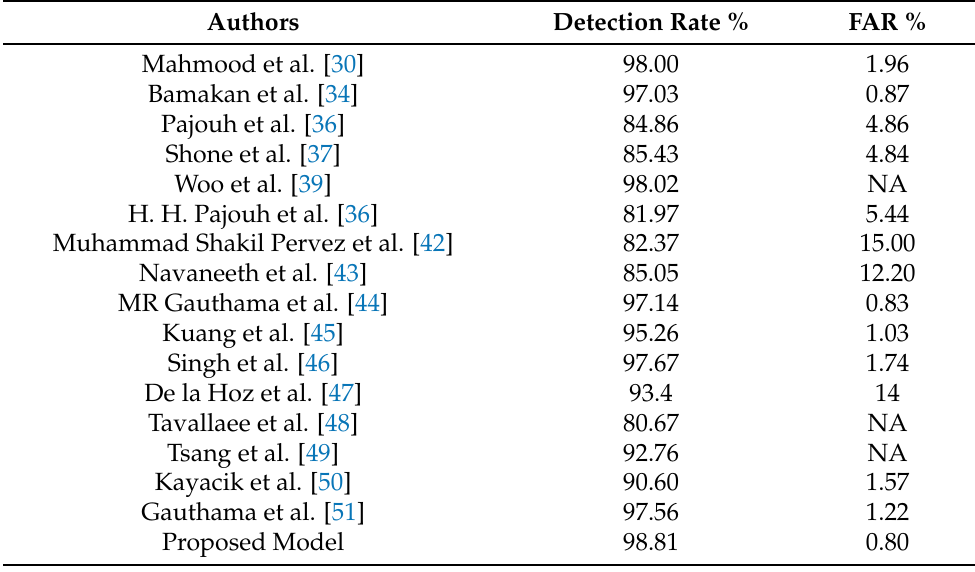
Table 8. Comparison of our proposed model with similar approaches used in other